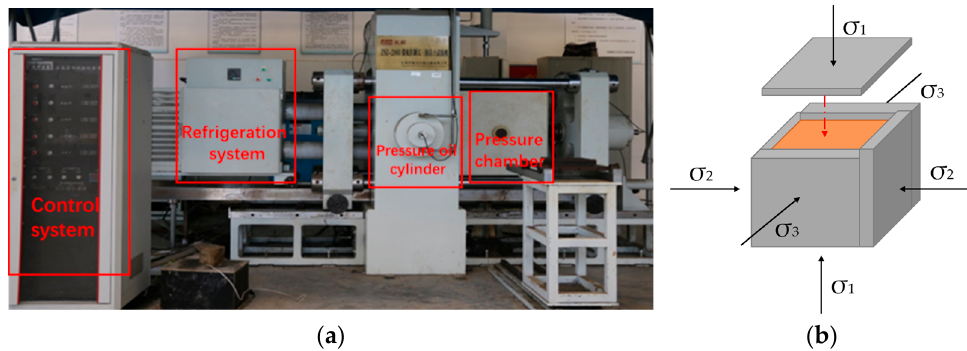
Figure 2. Test instrument and loading schematic diagram: ( a ) True triaxial testing machine; ( b ) Frozen soil sample and loading diagram. The arrows show the direction of each force.